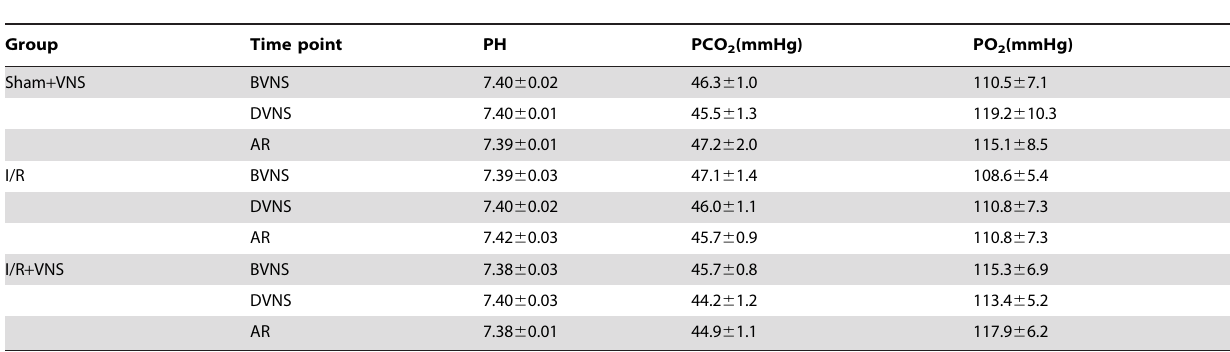
Table 1. Blood gas analysis for all three groups.